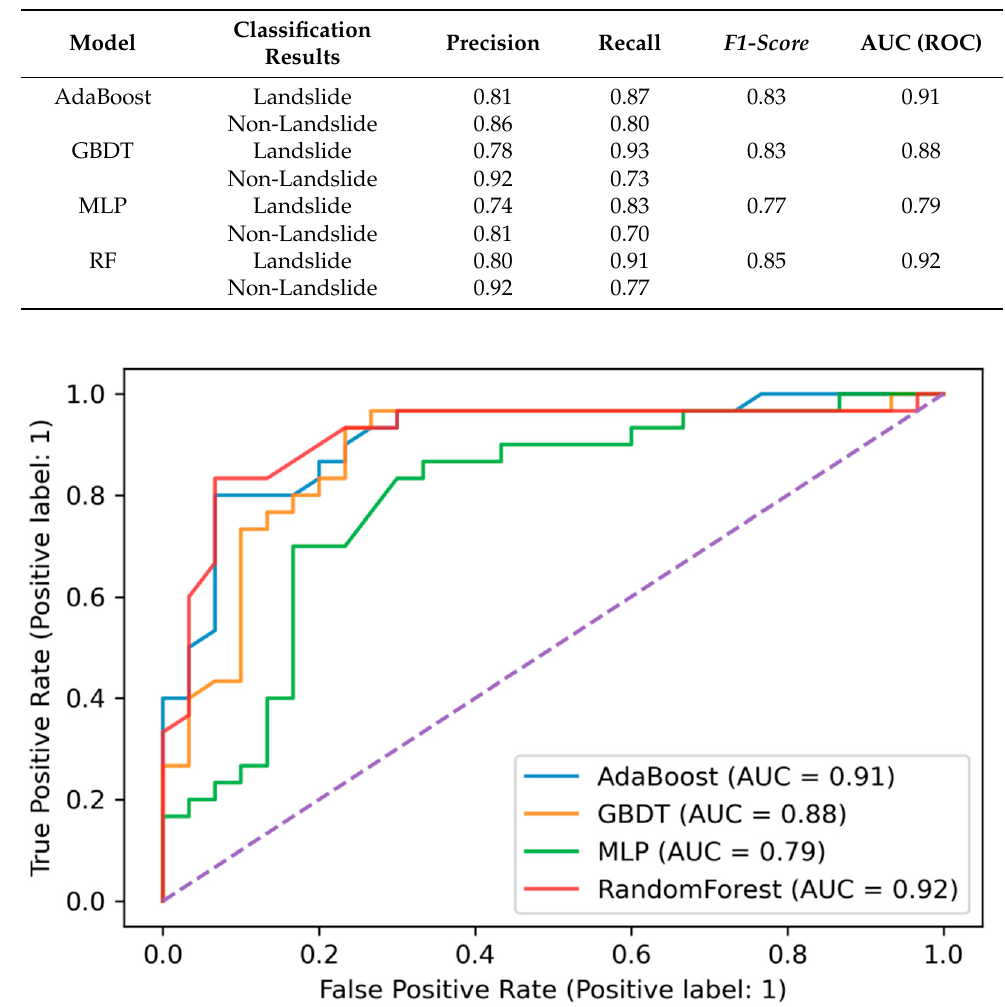
Figure 4. Area under the curve (AUC) values for the receiver–operating characteristic (ROC) curves for the four models.